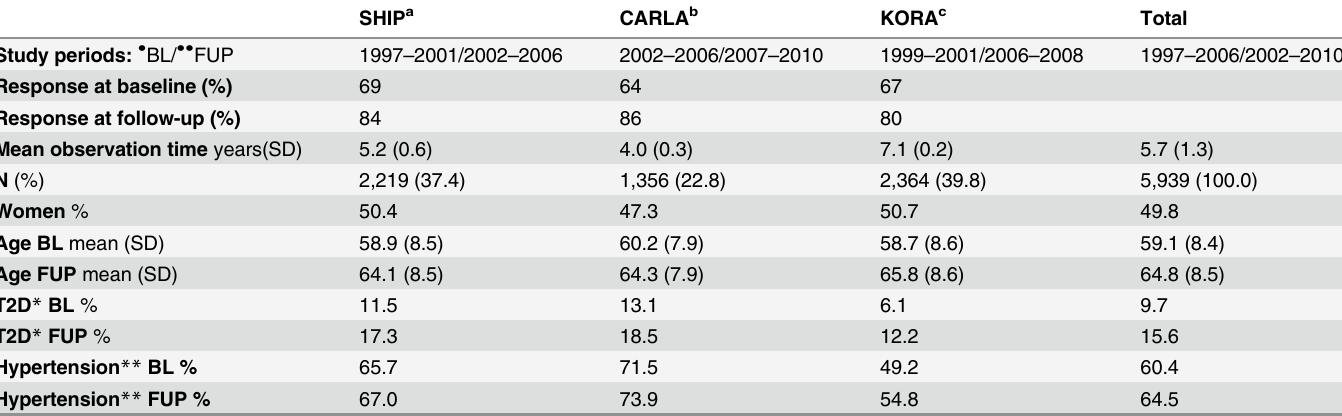
Table 1. Studies included in the pooled sample (45 – 74 years), N =